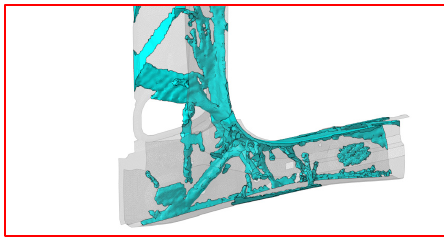
Figure 16. Reticular structure on Node G.